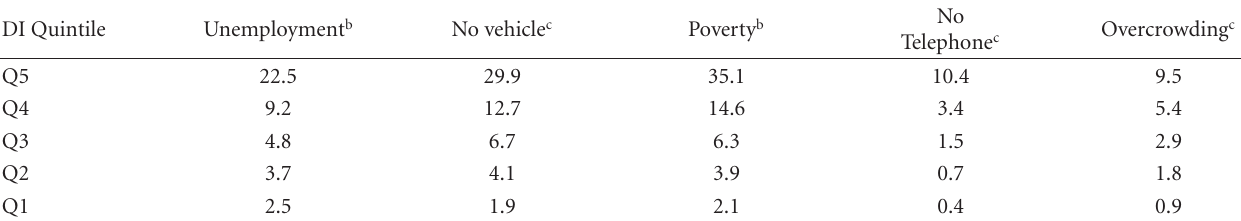
Table 2: Proportion of persons or households in each quintile of deprivation index a by the five parameters used to create the deprivation